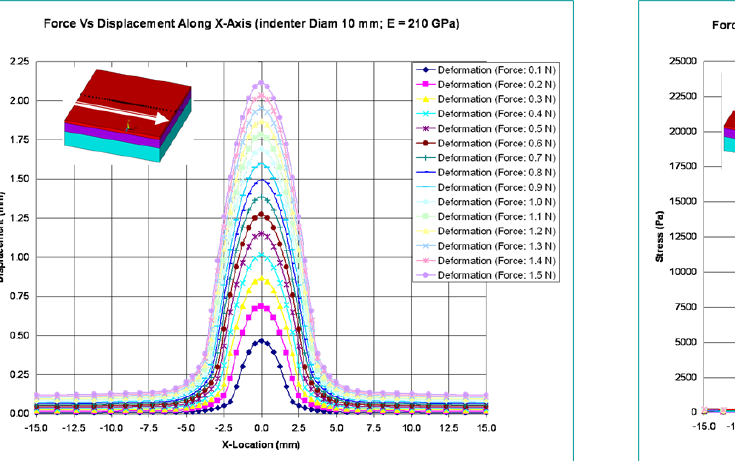
Figure 7. Deformation and Von-Mises stress along the length of the optical